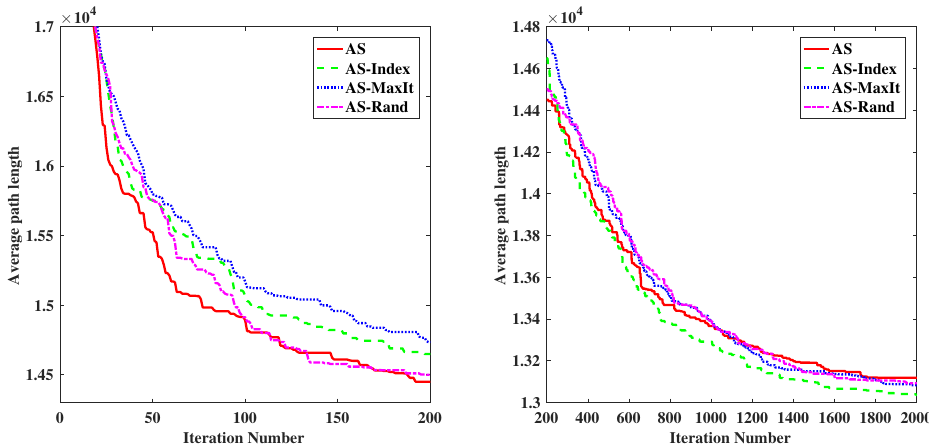
Figure 2. Evolutionary curves for different iteration periods based on